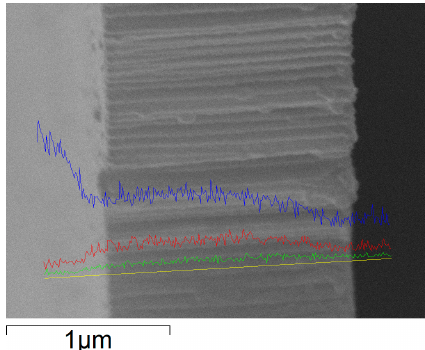
Figure 3. SEM image of the cross section for the NAAM with the deposited triple dielectric layer capacitor. On the left side, the substrate of Al can be seen, while on the right side, the NAAM surface appears where the pores are opened. EDX analysis has been carried out along the yellow segment, indicating the presence of different elements through it. The blue line corresponds to Al, while the red and green ones correspond to Si and Ti, respectively.